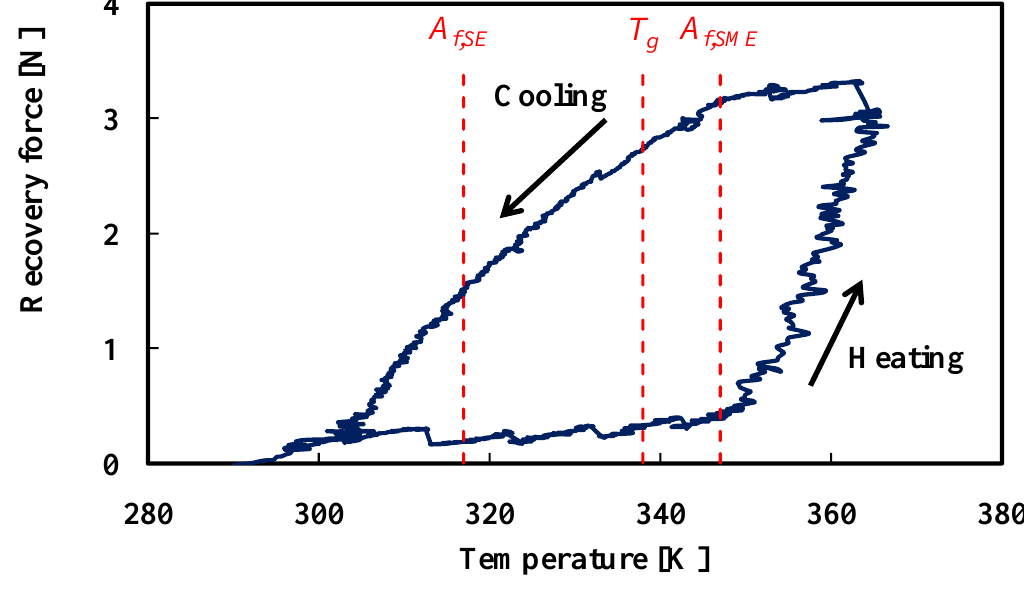
Figure 9. Relationship between recovery force and temperature during heating and cooling in the three-point bending test for the SMC